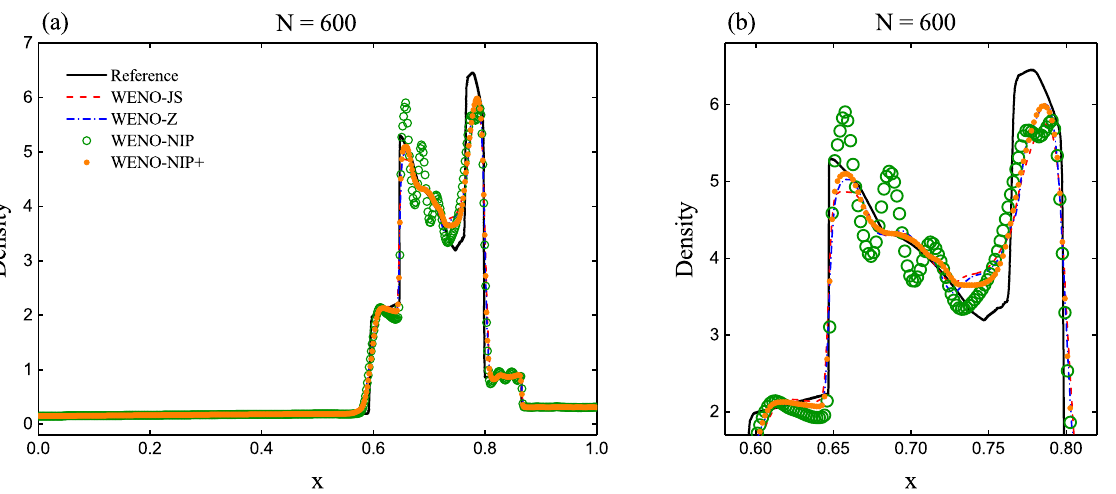
Figure 18. ( a ) Numerical solutions of the shock-density wave interaction of Titarev and Toro calcu- lated by WENO-JS, WENO-Z, WENO-NIP, and WENO-NIP+ at t = 5.0 with N = 1500. ( b ) Zoomed-in view of the high-frequency waves. ( c ) Zoomed-in view of the region before the high-frequency waves. Figure 19 plots the simulated density profiles of WENO-JS, WENO-Z, WENO-NIP, and WENO-NIP+. The reference solution is obtained by WENO-JS in the charateristic- wise framework with a refined uniform mesh of N = 10,000. It is evident that WENO- NIP generates severe spurious oscillations and falsely amplifies the solution. However, WENO-NIP+ almost removes the spurious oscillations and avoids the false amplification successfully. Furthermore, it appears that WENO-NIP+ performs slightly better than WENO-JS and WENO-Z for this test.